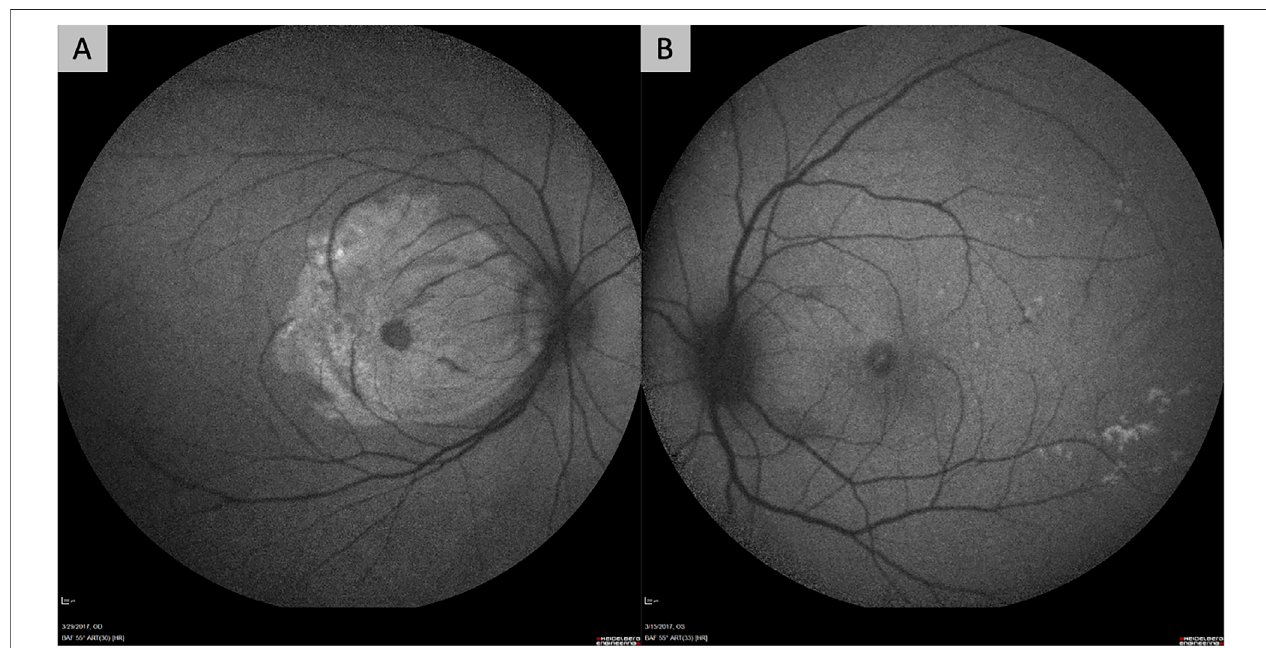
FIGURE1| Fundusauto fl uorescenceimagesofnon-humanprimateeyesdemonstratingtheimprovedef fi cacyofretinalgenetransfectionaftersurgicalremovalof theinternallimitingmembrane(ILM).Botheyesinthe fi gurehadintravitrealdeliveryofAAV2vectorcarryingthegeneforgreen fl uorescentprotein(GFP)afteraparsplana vitrectomy.Oneeye (A) hadsurgicalpeelingoftheILMoverthemaculapriortoexposuretotheAAV2vector,whiletheothereye (B) didnot.TheeyethatunderwentILM removal (A) shows signi fi cant hyper-auto fl uorescence over the macular region from GFP expression, while the other does not (B) .